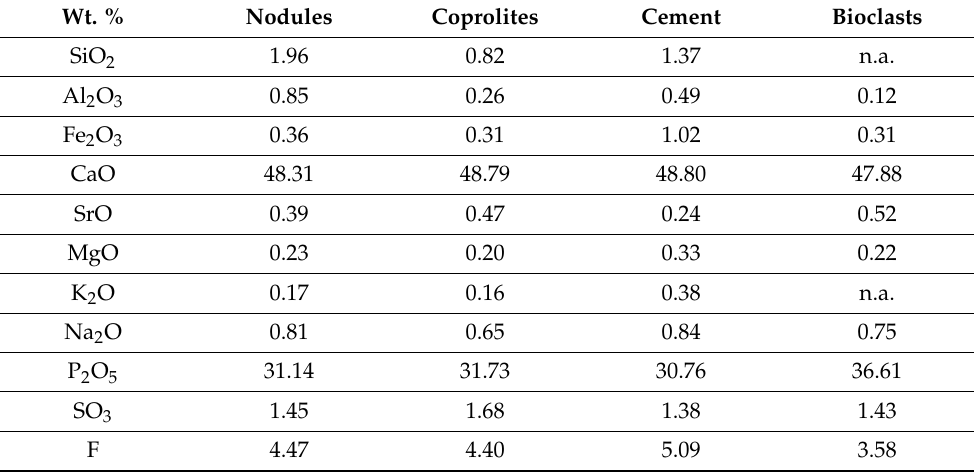
Table 2. Average EDS microanalysis of the apatite in various phosphate components.